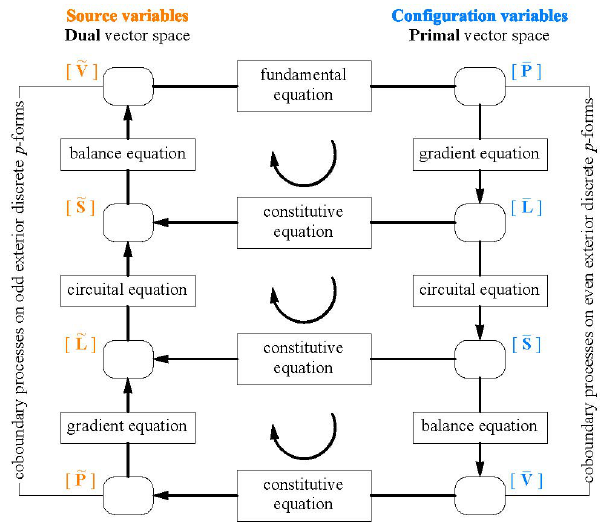
Figure 4: Classification diagram of the physical variables in the fundamental